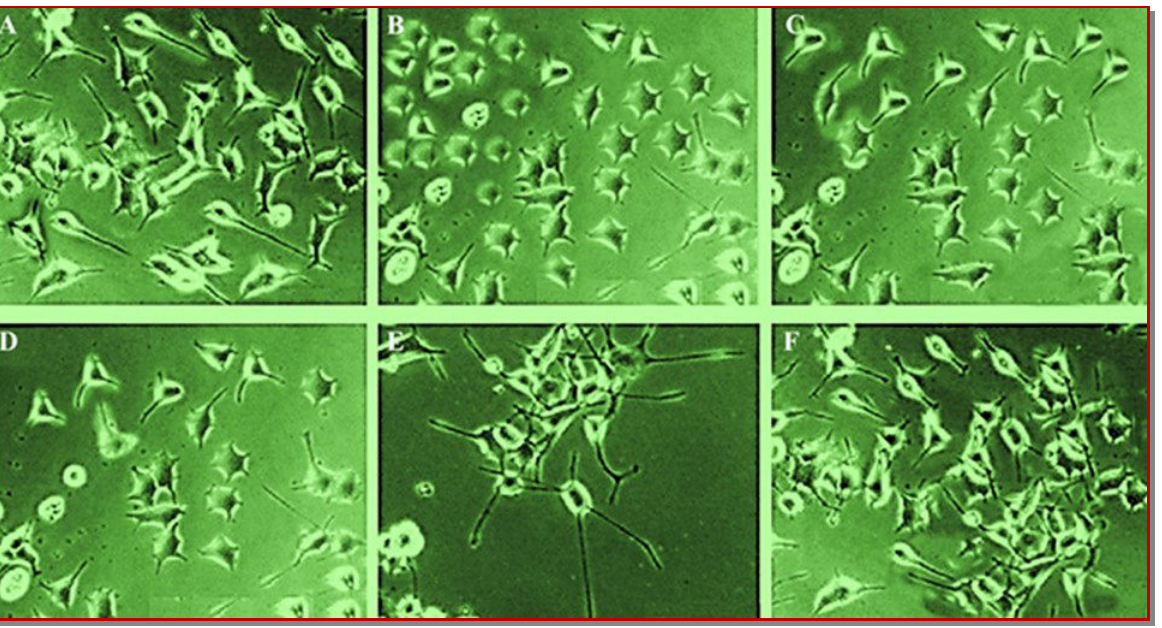
Figure 3: Effect of various doses of theaflavin-3-gallate on the neurite outgrowth of N2a cells measured by inverted light micro- scope (400x magnification at retinoic acid treated cells (A); 1-methyl-4-phenyl pyridinium (20 µM) treated cells (B); 5, 10, 50 and 100 µM theaflavin-3-gallate-treated cells (C-F) respectively. The neurite outgrowth can be clearly seen in theaflavin-3-gallate- treated cells